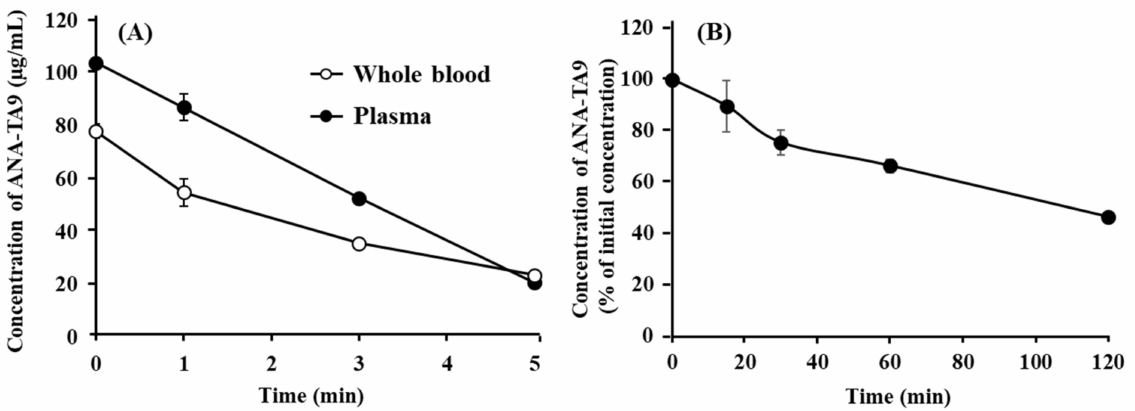
Figure 1. Concentration profiles of ANA-TA9 in the plasma after ( A ) bolus intravenous injection and ( B ) constant intrave-